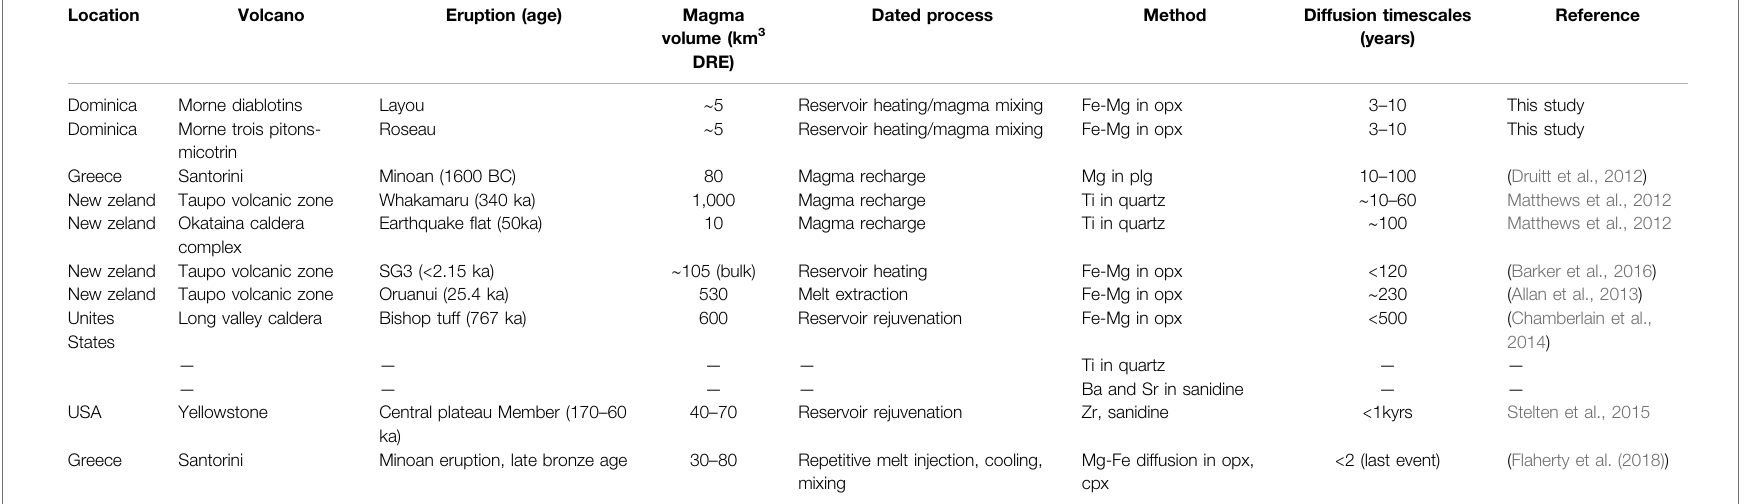
TABLE 3 | Comparison of diffusion timescales obtained for different large volume silicic